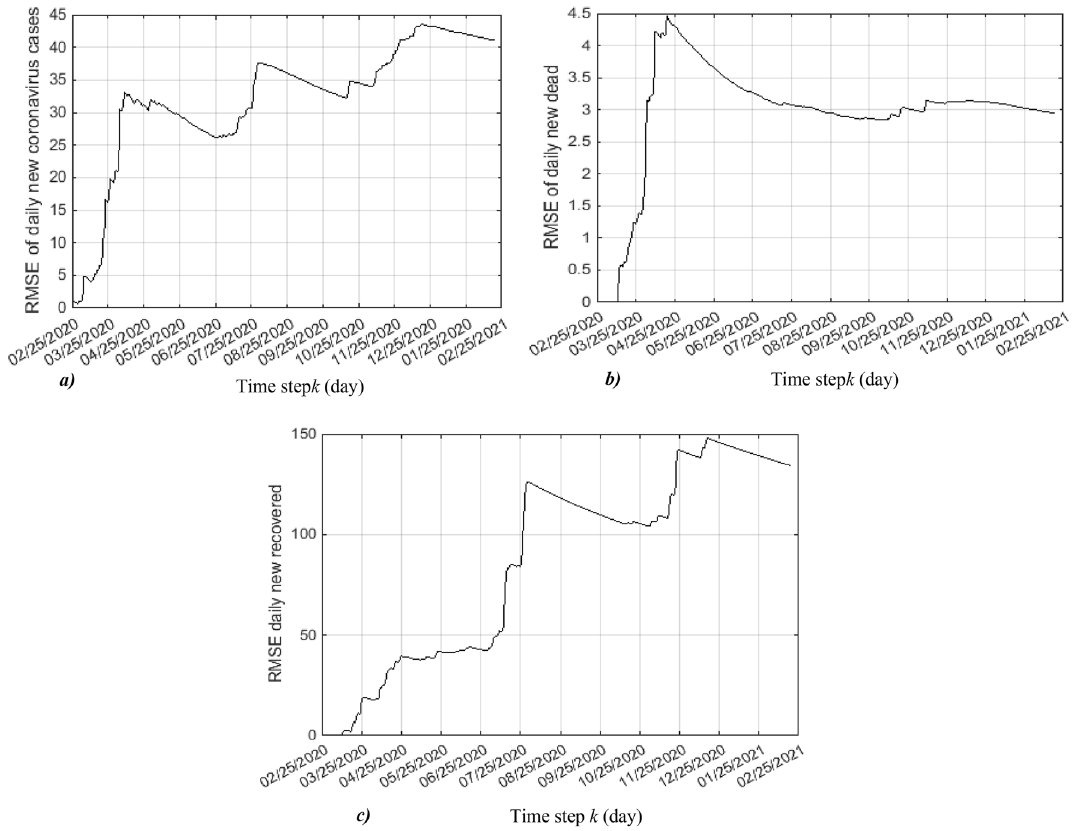
Figure 9. RMS error of: ( a ) daily new coronavirus cases, ( b ) daily new dead and ( c ) daily new